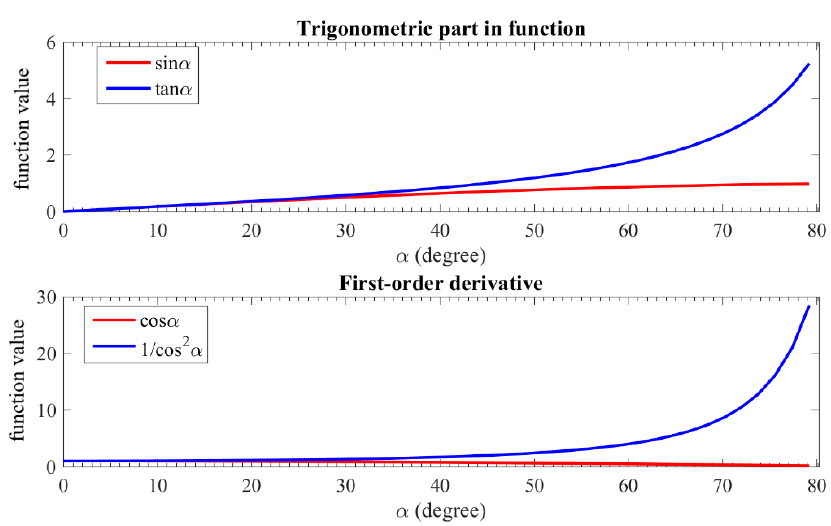
Figure 4. The variation tendency for the trigonometric part.